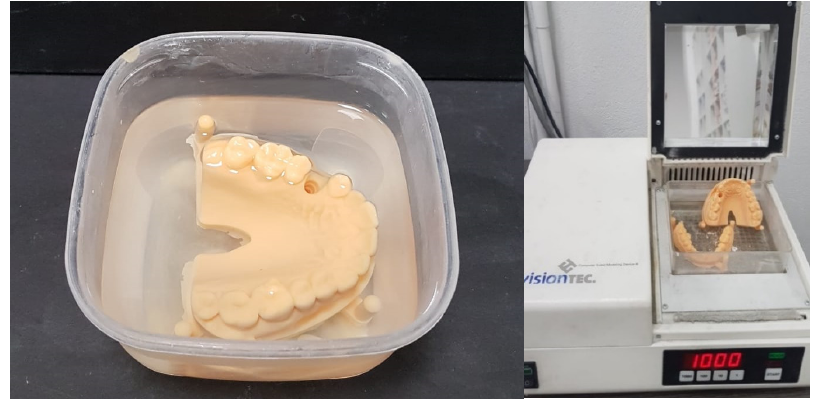
Figure 2. 3D vat photo-polymerized models, cleaned with isopropanol, and post-polymerized.